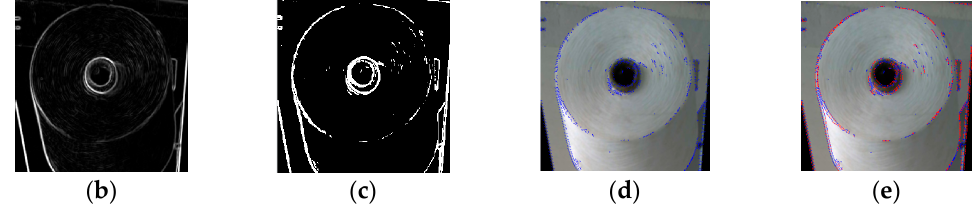
Figure 9. Image process and contour points extraction. ( a ) Gray image. ( b ) Gradient image. ( c ) Binary image. ( d ) Contour points. ( e ) Points interpolation.